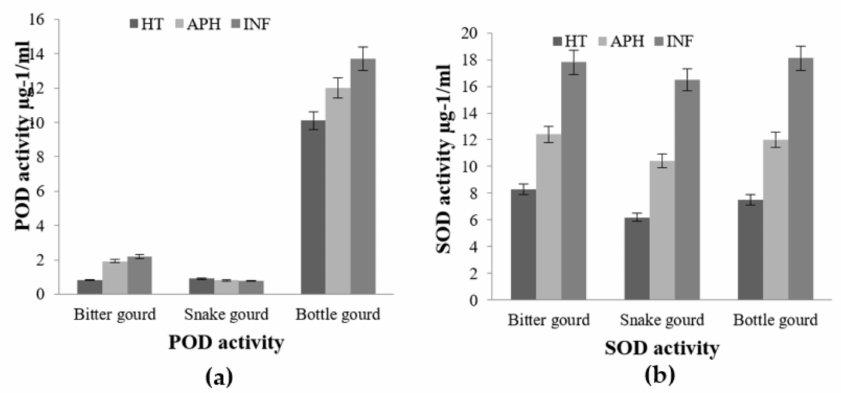
Figure 5. Comparison of peroxide (POD) and superoxide dismutase (SOD) enzyme activity in healthy (HT), apparently healthy (APH), and infected (INF) tissues of selected cucurbit fruit Bitter gourd, Snake gourd and Bottle gourd ( a ) and Chayote and Cucumber ( b ) upon melon fly infection. The vertical bars indicate the standard error. Significance at p ≤ 0.05.